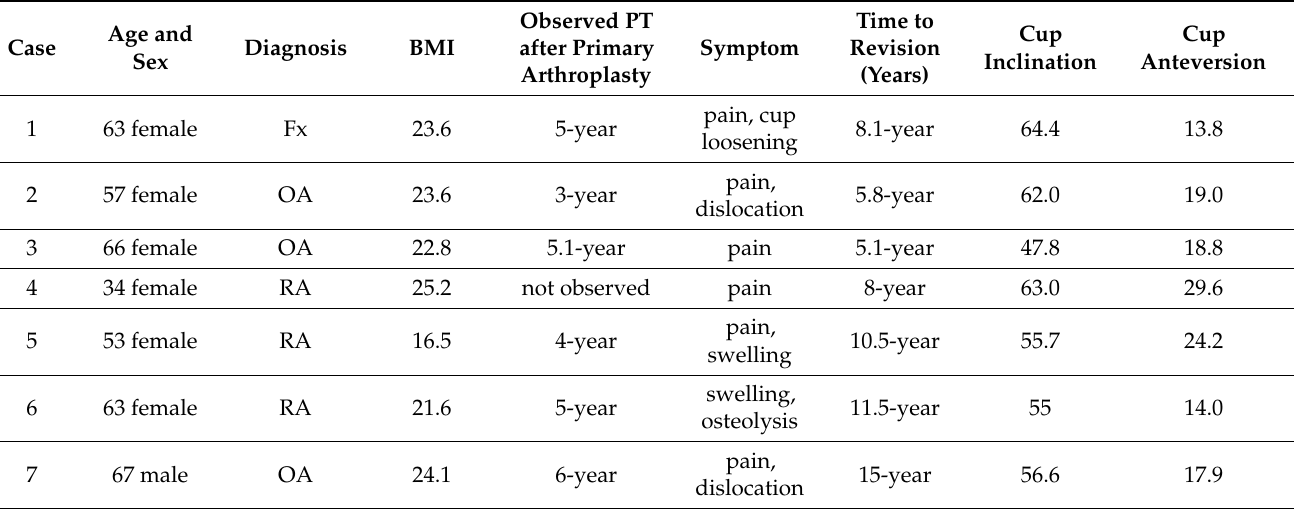
Table 1. Revision cases. Seven hips were switched to a metal-on-polyethylene articulation from 5.1 years to 15 years postoperatively because of pain and swelling. Fx, secondary hip OA in post- traumatic fracture; OA, osteoarthritis; RA, rheumatoid